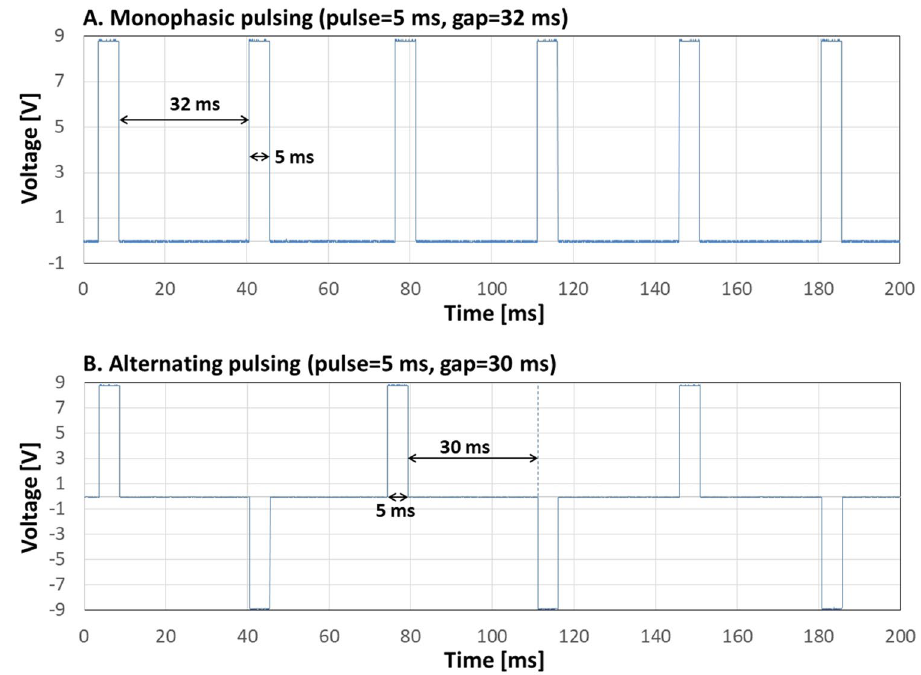
Figure 3. Monophasic and alternating pulses measured with an oscilloscope. ( A ) Shows a sequence of six monophasic 5 ms-pulses, followed by a gap of 32 ms. ( B ) Shows a sequence of six alternating 5 ms-pulses, followed by gaps of 30